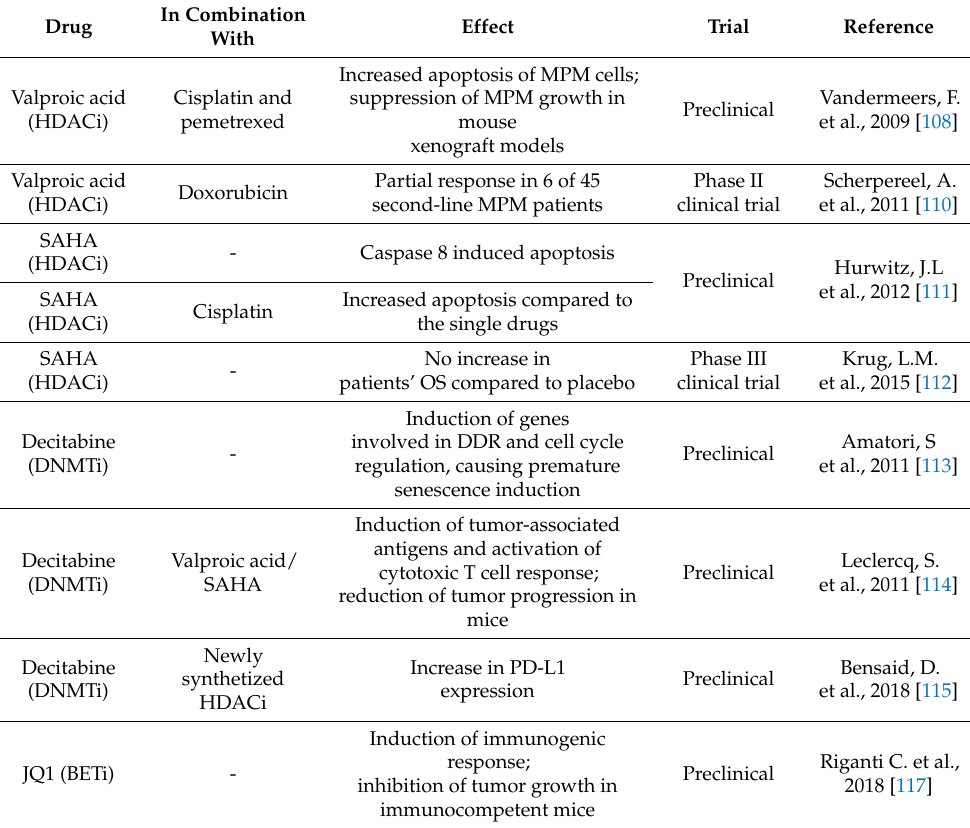
Table 1. Epigenetic drugs tested in clinical and preclinical trials for MPM treatment. In Combination Drug